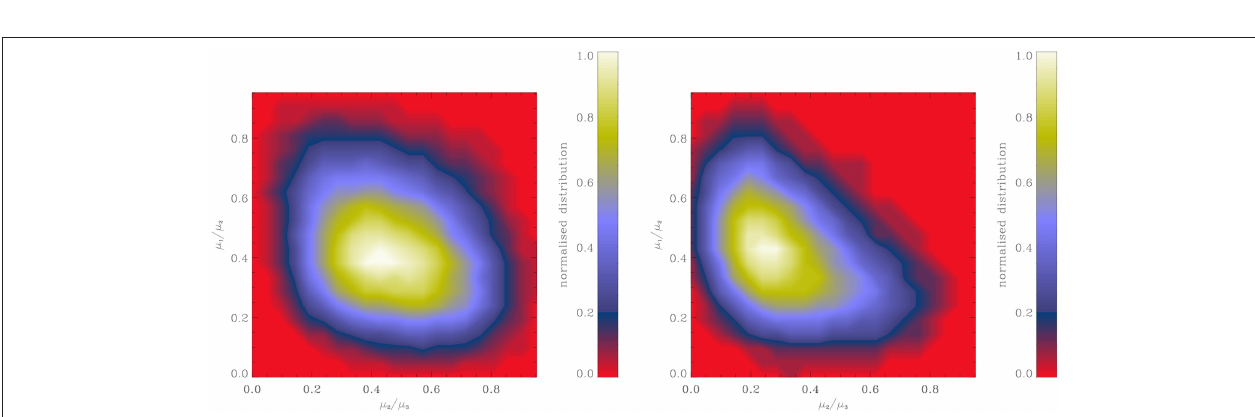
FIGURE 10 | Normalized bidimensional histogram displaying µ 1 /µ 2 as a function of µ 2 /µ 3 where µ 1 , µ 2 , and µ 3 are the inertia matrix eigenvalues, µ 1 being the smallest (from Hennebelle, 2013). (Left panel) Hydrodynamical simulation. (Right panel) MHD simulation. Clearly the MHD run present structures that on average tends to be more elongated (i.e., have a smaller µ 2 /µ 3 ) than the hydrodynamical ones. Reproduced from Hennebelle (2013) with permission of A&A.